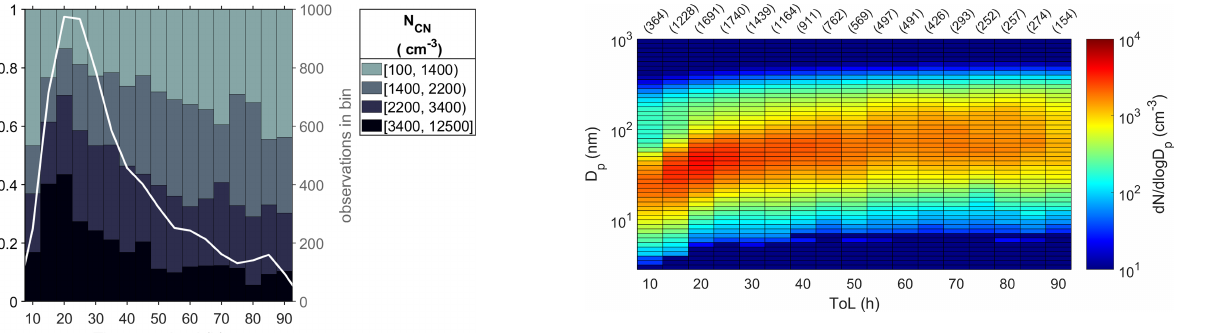
Figure 4. Median aerosol number size distribution in air masses with different ToLs. The numbers on top show the number of tra- jectories in each